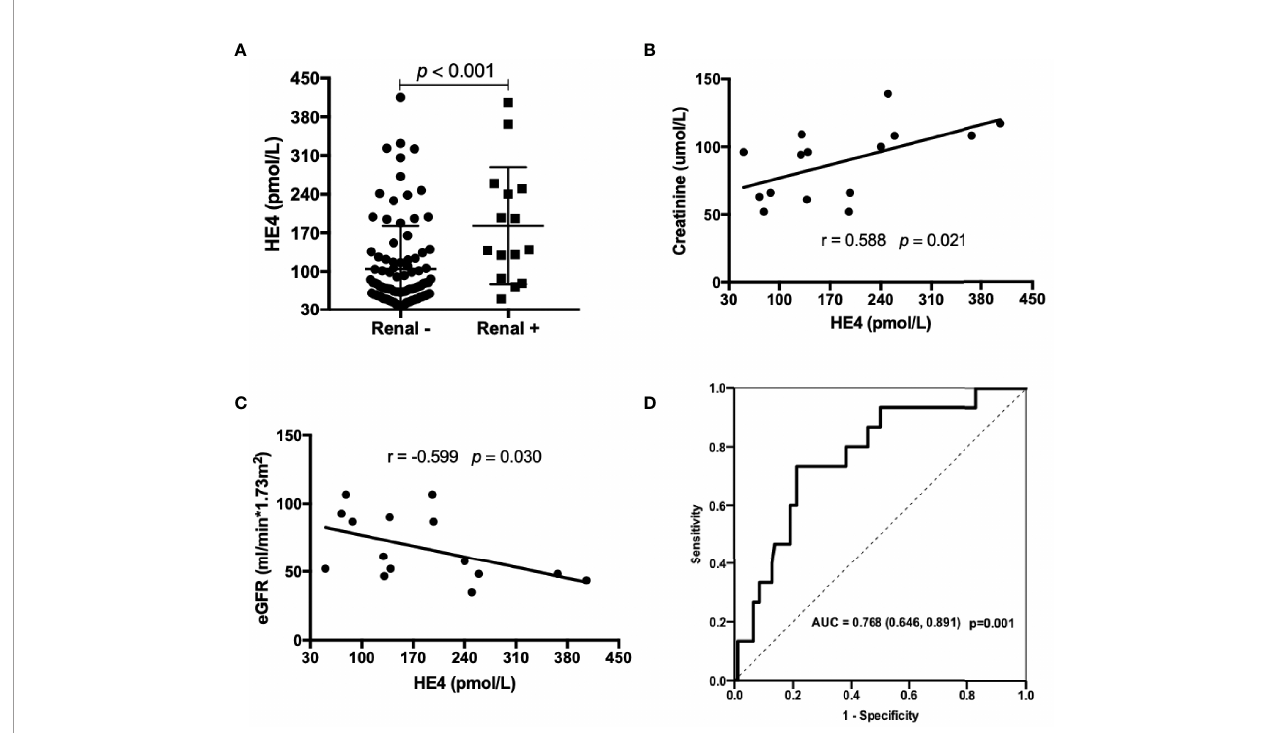
FIGURE 3 | Associations between the levels of HE4 and renal involvements. (A) Patients with renal involvement (n=15) had higher levels of HE4 than those without renal involvement (n = 94). (B, C) Serum levels of HE4 was positively correlated with creatinine and negatively correlated with eGFR (n = 15). (D) Receiver operating curve (ROC) analysis on the clinical performance of HE4 in identifying patients with renal involvement. Statistical signi fi cance was determined by Mann-Whitney U test, Spearman ’ s correlation test and ROC analysis. eGFR, estimated glomerular fi ltration